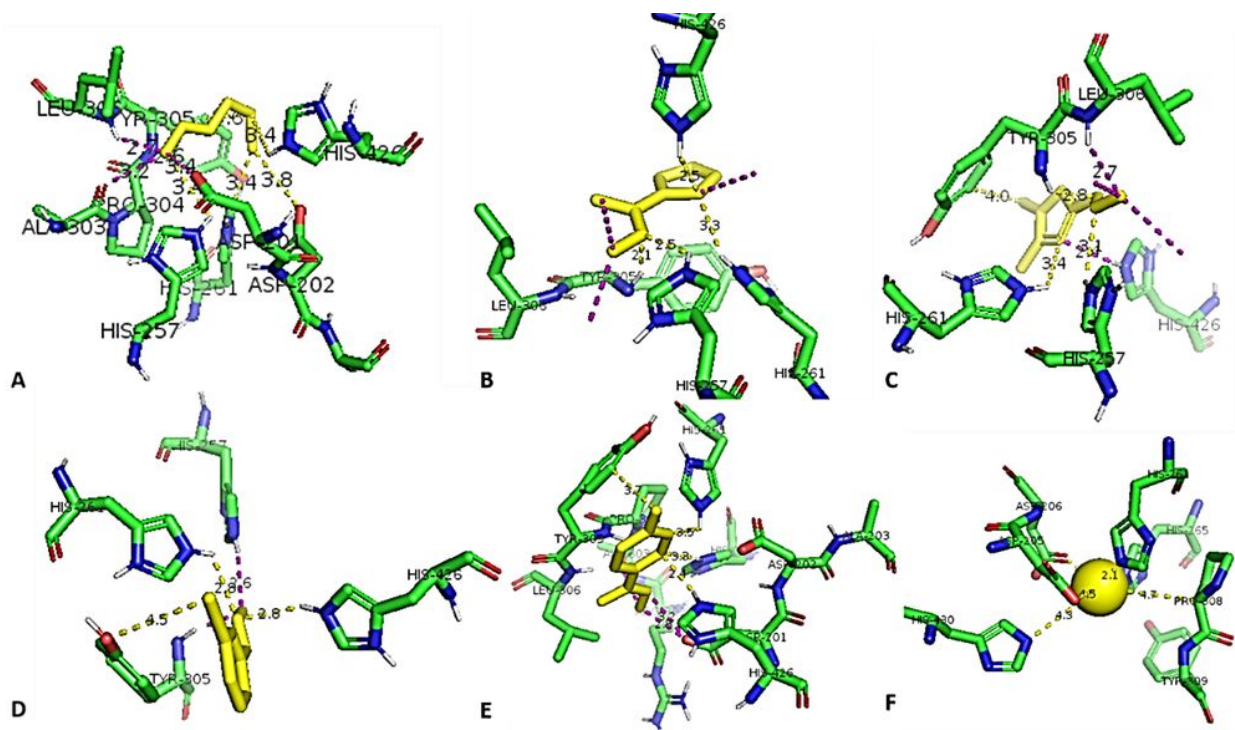
Figure 8. Interaction between the selected molecules, in yellow, with the amino acid residues, in green, of the macromolecule Bombyx-Aedes model, in green. ( A ) M01 (ZINC13514543); ( B ) M02 (ZINC14413017); ( C ) M03 (ZINC05680928); ( D ) M04 (ZINC04691148); ( E ) M05 (ZINC95851150); ( F ) Zinc Ray.